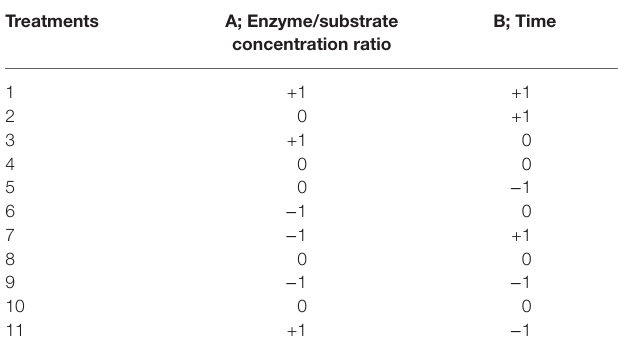
TABLE 2 | Treatments generated based on the central composite design to hydrolysis conditions. Treatments A; Enzyme/substrate concentration